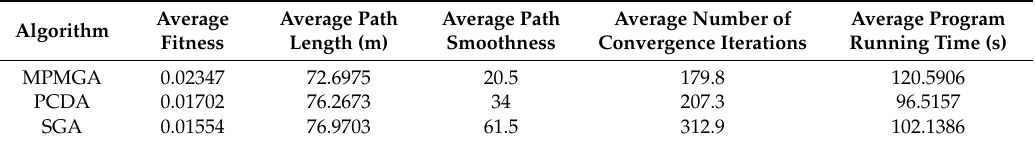
Table 7. Data comparison table of the three